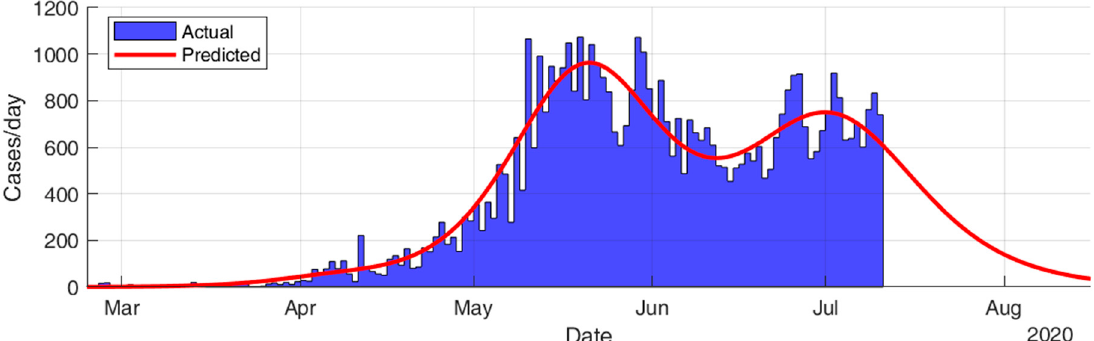
Figure 22. Prediction results for infection cases in Kuwait.